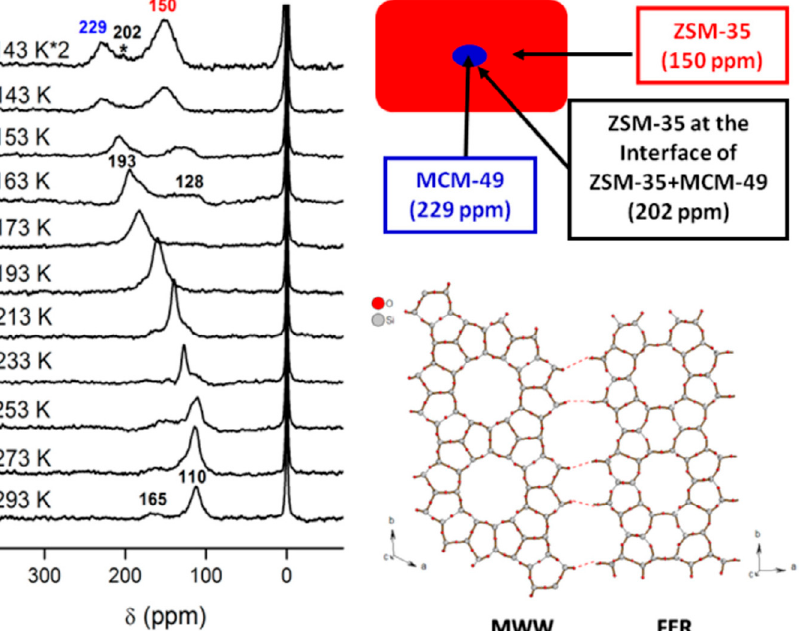
Figure 3. Temperature-dependent hyperpolarized 129 Xe Nuclear Magnetic Resonance (NMR) spectra of Xe adsorbed in the obtained FER zeolite sample and the possible linkage between the structures of MCM-49 and FER. Reprinted with permission from ref. [87]. Copyright 2014, Elsevier.